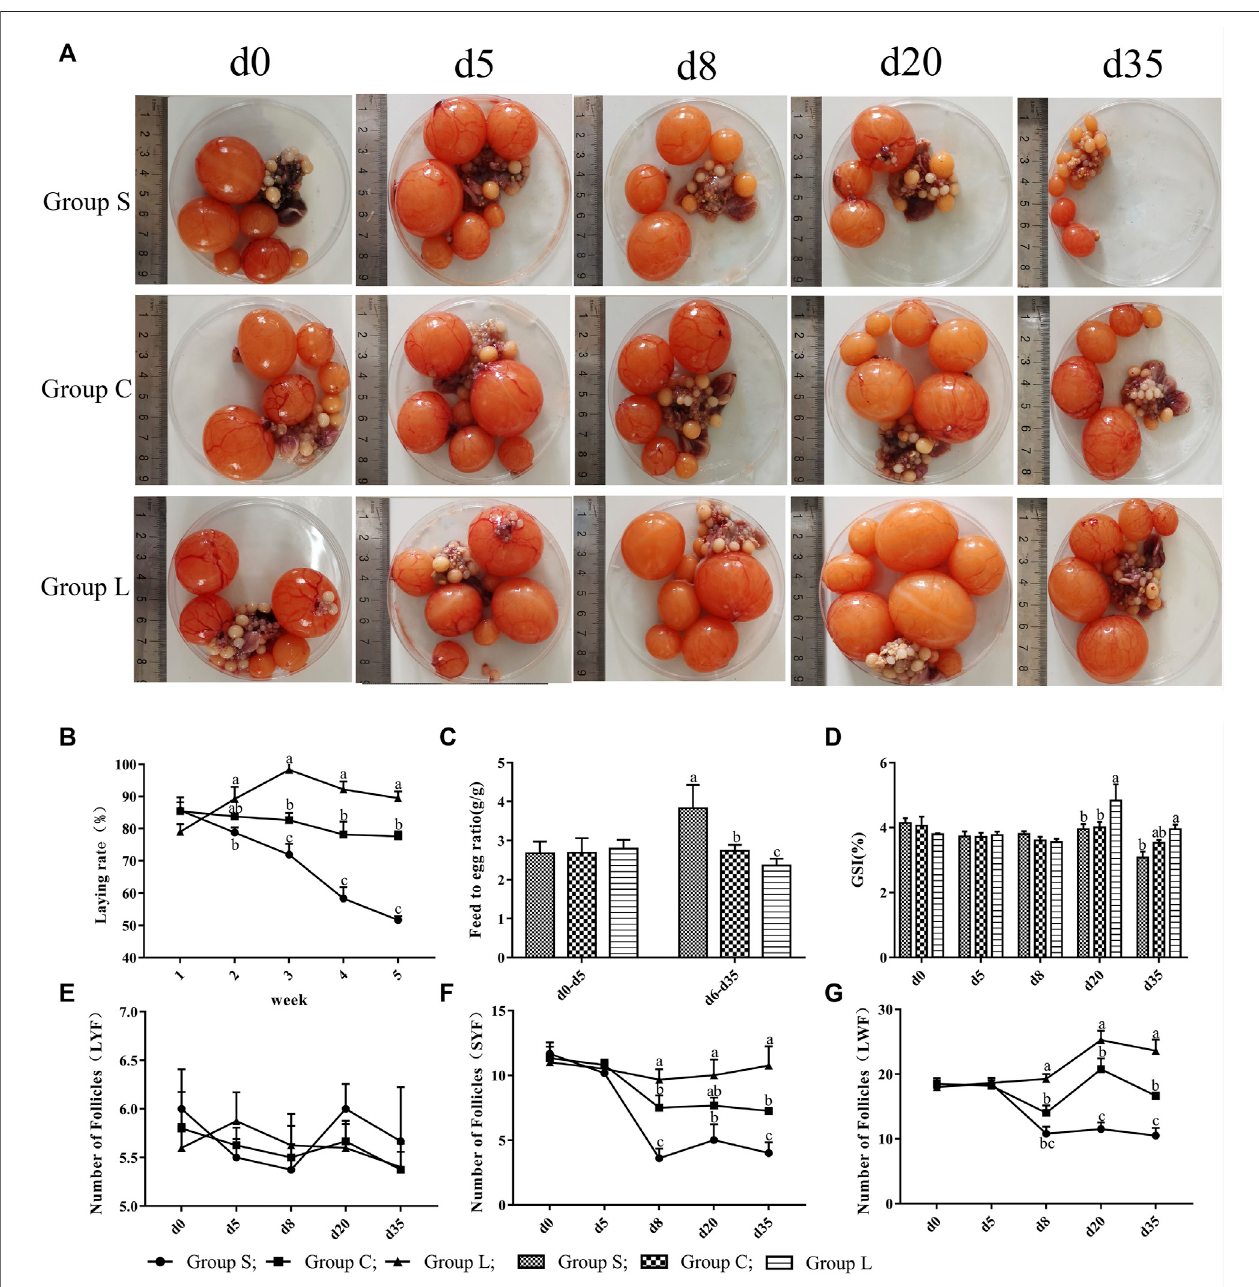
FIGURE 2 | Laying performance and follicular development of mountain ducks under different photoperiods. 1 (A) , pictures of the follicles of the mountain ducks; 1 (B) , egg production of mountain ducks; 1 (C) , feed-to-egg ratio of mountain ducks; 1 (D) , ovarian index of mountain ducks; 1 (E) ,1 (F) ,1 (G) , number of follicles of mountain ducks. Consecutive letters (A,B) indicate signi fi cant differences( p < 0.05), and discrete letters (A,C) indicate highly signi fi cant differences ( p < 0.01), the same as below.